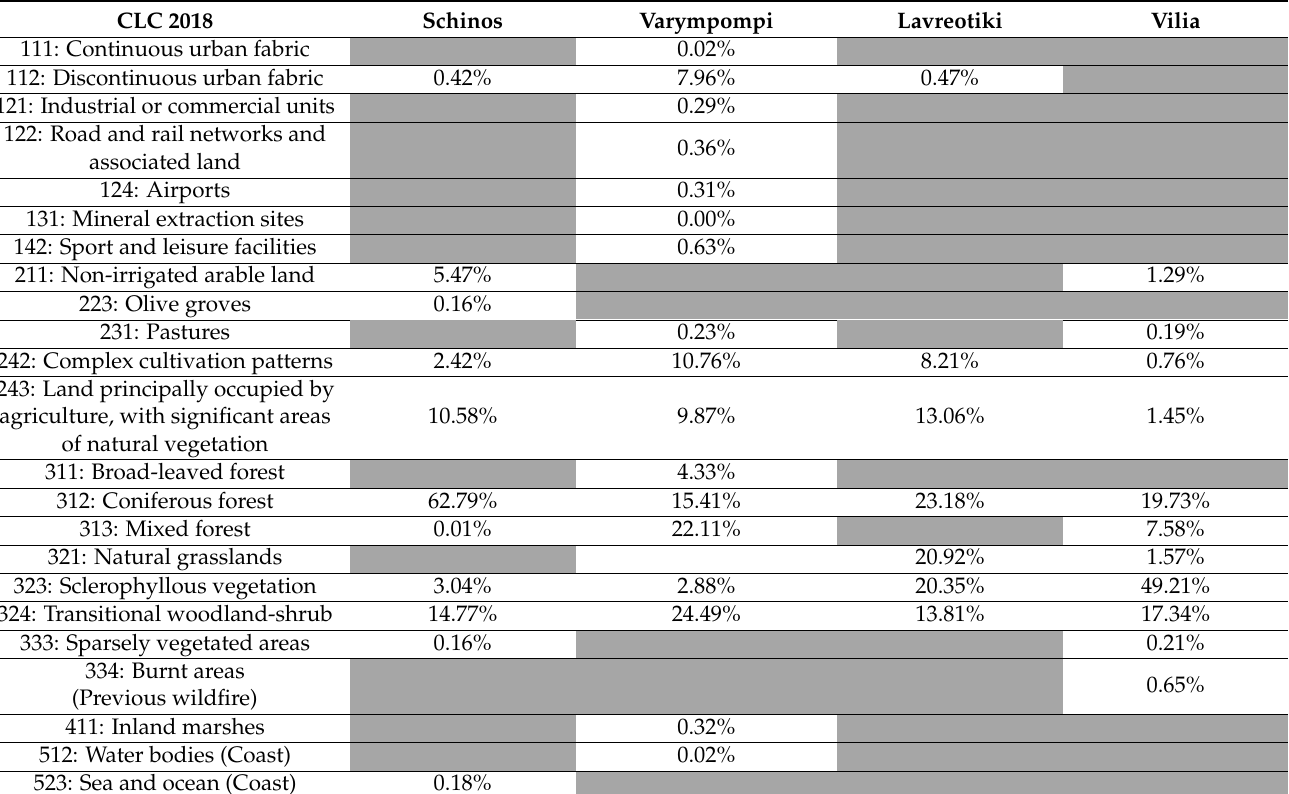
Table 4. Burned land cover of Attica region wildfires based on Corine Land Cover 2018 (% of the burned area total of each area per land cover